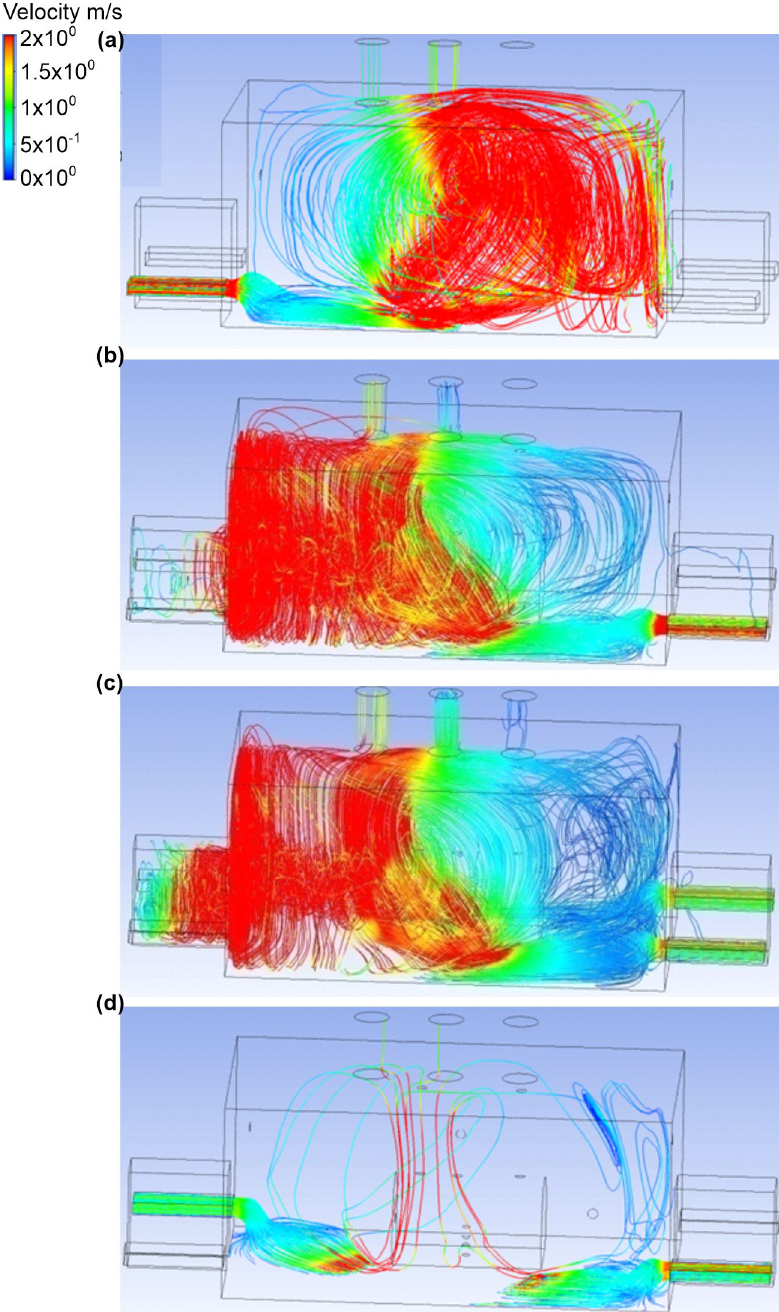
Figure 17. Velocity distribution in the engine room for: ( a ) scenario A, ( b ) scenario B, ( c ) scenario C, and ( d ) scenario D.